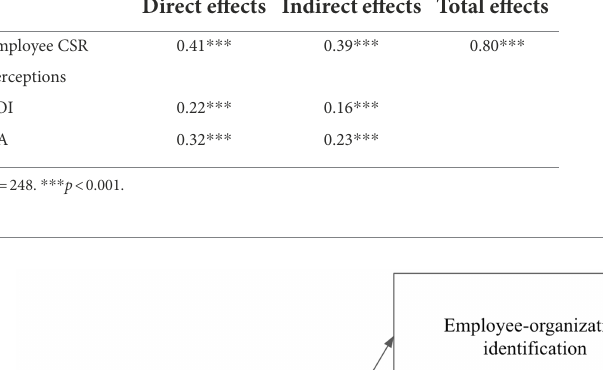
TABLE 4 Standardized direct and indirect effects of employee CSR perceptions on